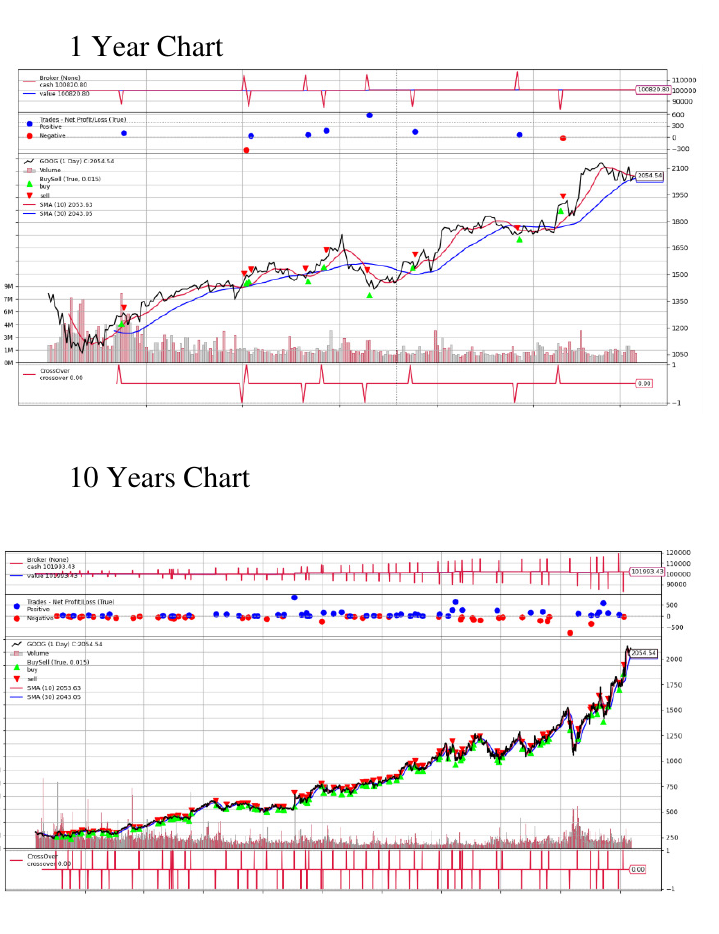
Figure 17: Moving Average Back testing